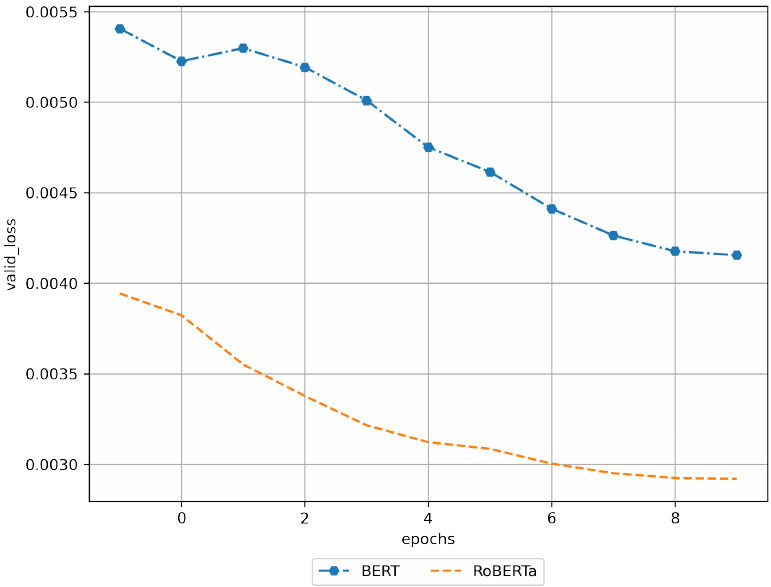
Figure 6. Evolution of the validation_loss of neural networks devoted to filling in the blanks during the training